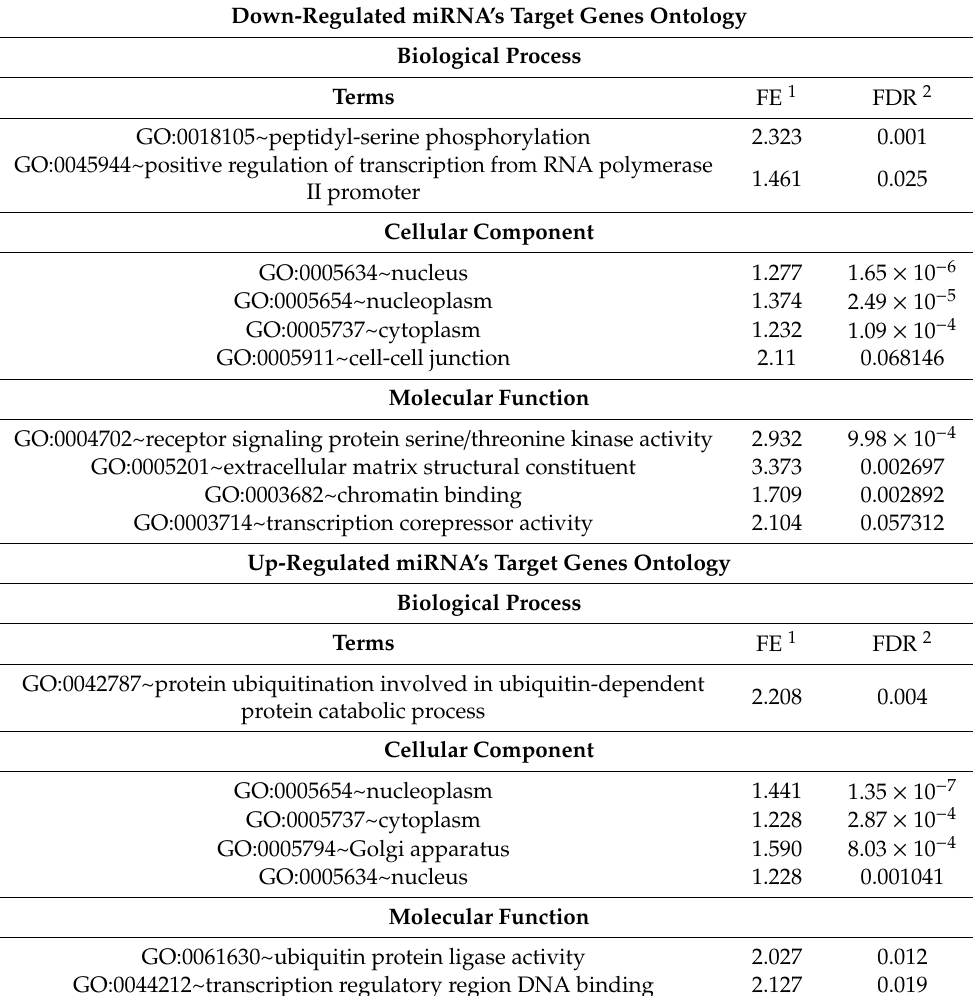
Table 1. Gene ontology (GO) functional analysis of the target genes of di ff erentially expressed